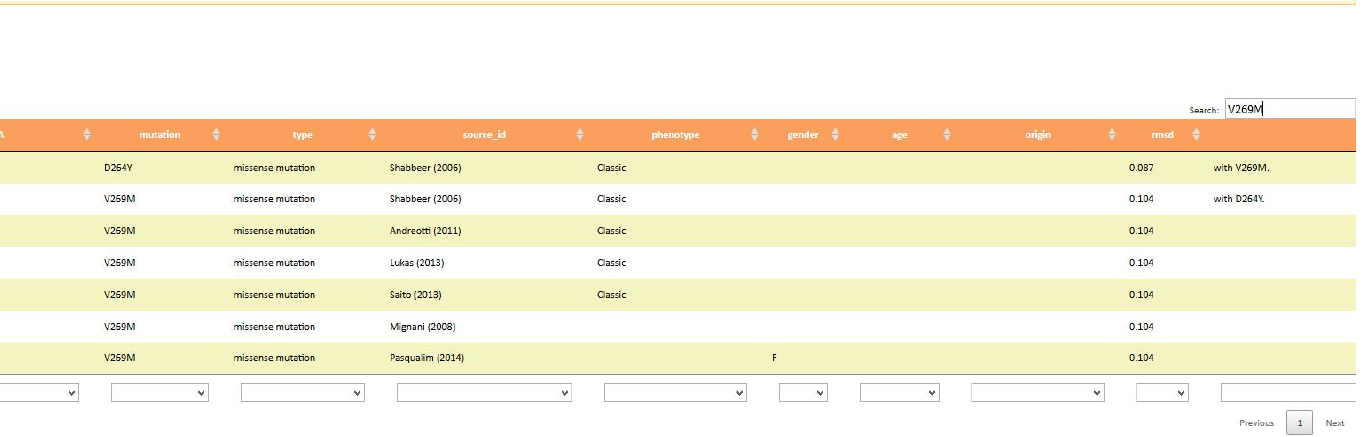
Figure 4. Output of fabry-database.org.